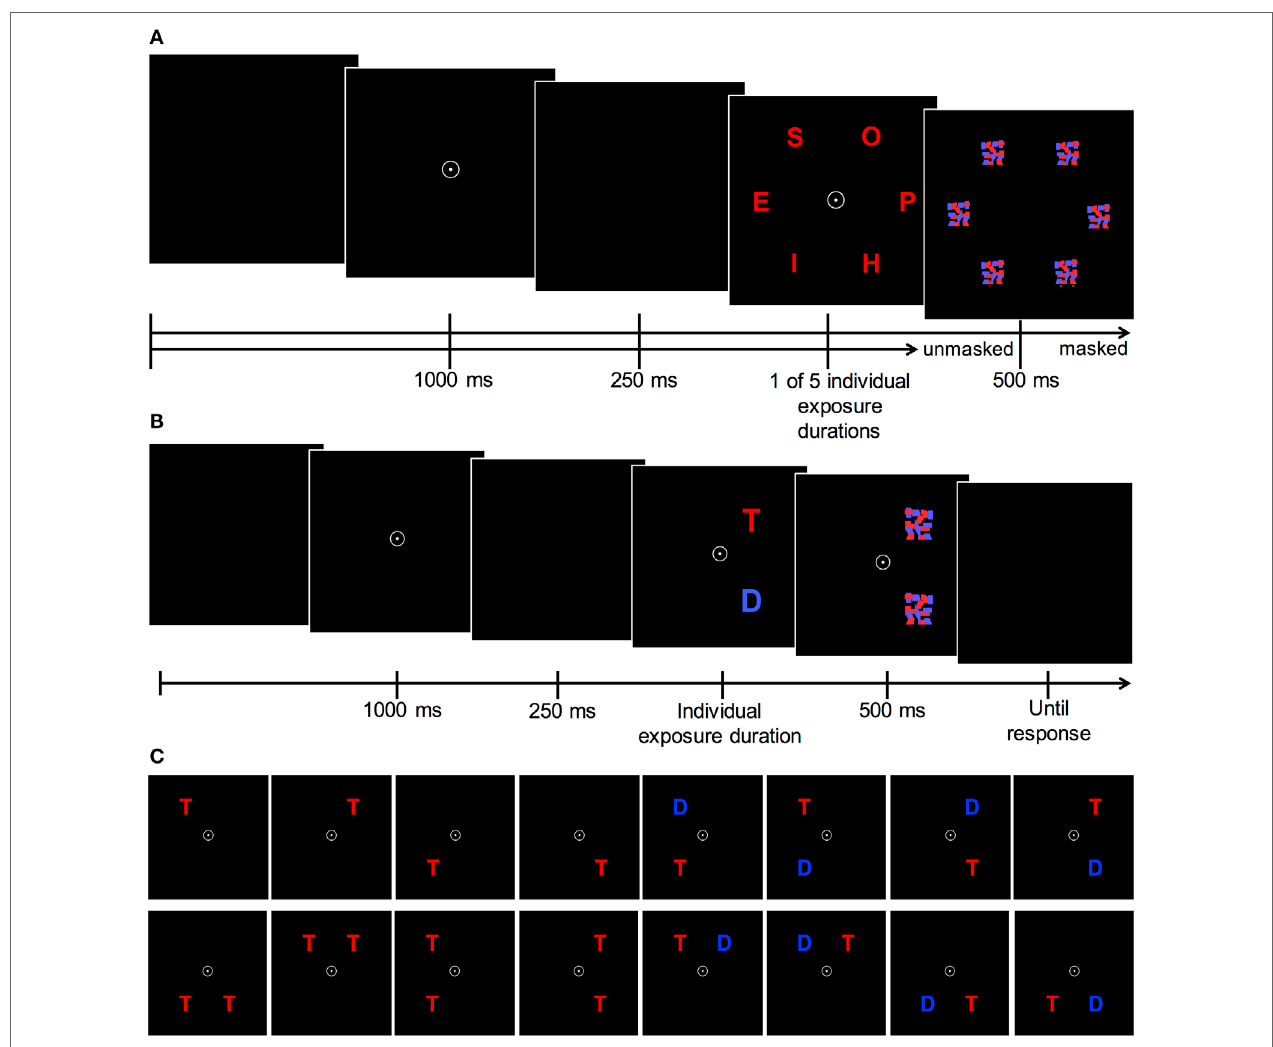
FiGUrE 2 | (a) Theory of Visual Attention (TVA) whole-report task procedure. After the presentation of a central fixation circle for 1,000 ms and a brief delay of 250 ms, six letters are flashed in an imaginary circle either in red or blue font for one of five individually adjusted exposure durations (identified in a pretest). In these five exposure duration conditions letters were masked for 500 ms. In two unmasked conditions, letters were presented in the second shortest and the longest exposure duration condition. (B) Trial sequence and (C) display types of TVA partial-report task. After the presentation of a central fixation for 1,000 ms and a brief delay of 250 ms, one of the 16 possible display types appears for a predetermined individual exposure duration. Following that, presented stimuli (T = target = red letters; D = distractor = blue letters) are masked for 500 ms. Adapted according to Gögler